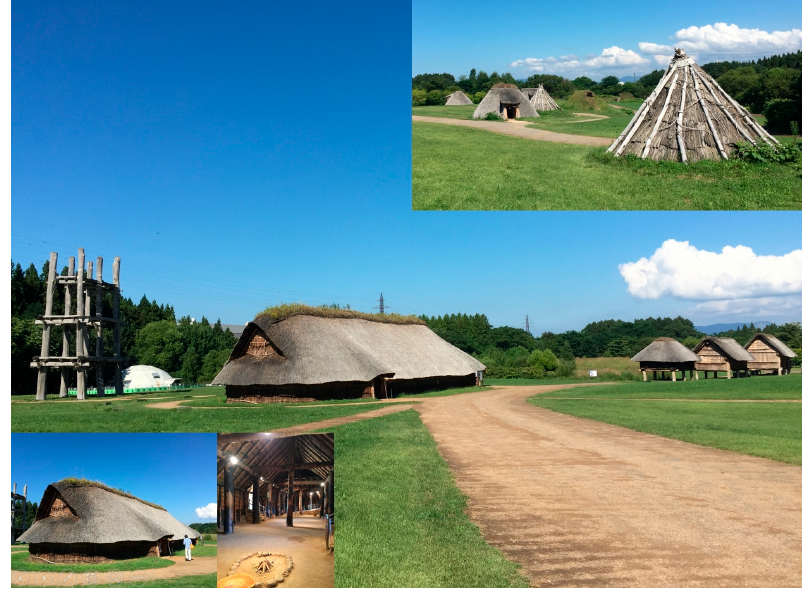
Figure 8. Sannai-Maruyama special historical site in Japan.